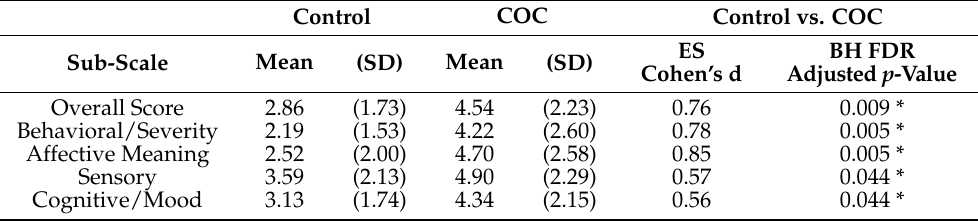
Table 3. Results from the Piper Fatigue Scale (PFS). The Behavioral/Severity subscale measured the impact fatigue might have had on activities of daily living; the Affective Meaning subscale determined the emotional meaning attributed to fatigue; the Sensory subscale analyzed the mental, physical, and emotional symptoms of fatigue; the Cognitive/Mood subscale analyzed the effect fatigue might have had on cognitive function and mood. SD, Standard deviation. ES, effect size. Cohen’s d value: 0.2, small effect; 0.5, medium effect; 0.8, large effect; 1.3, very large effect. * The BH FDR adjusted p -value was considered significant when ≤